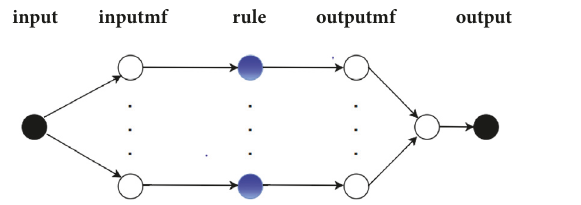
Figure 2: The ANFIS